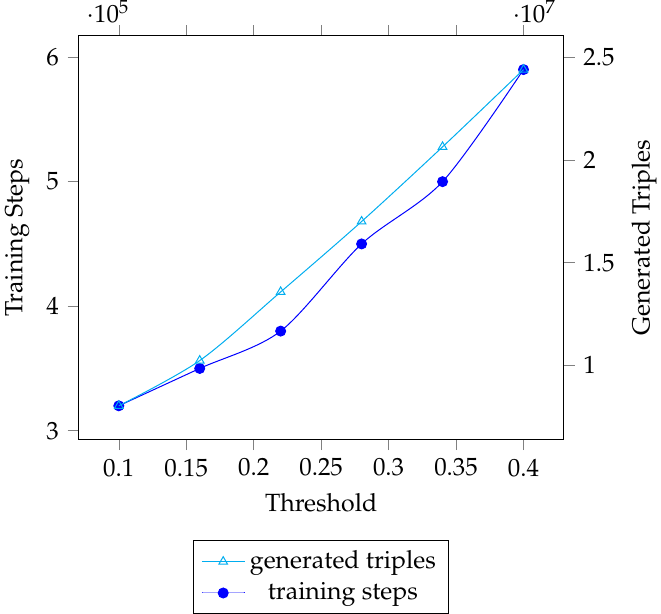
Figure 4. This figure shows the model performance with different thresholds t different amounts of new triples. When the amount of new triples grows, the model performs worse since the data quality is worse. since the data quality is worse.